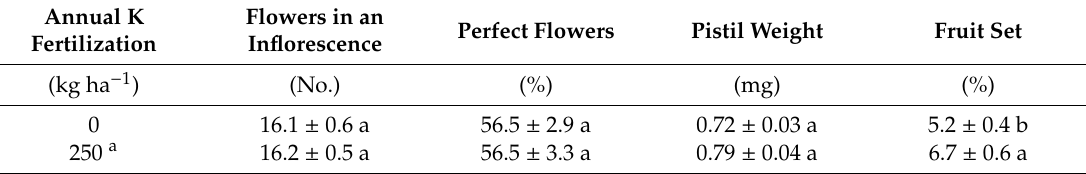
Table 2. Influence of K fertilization on flowering quality traits and fruit